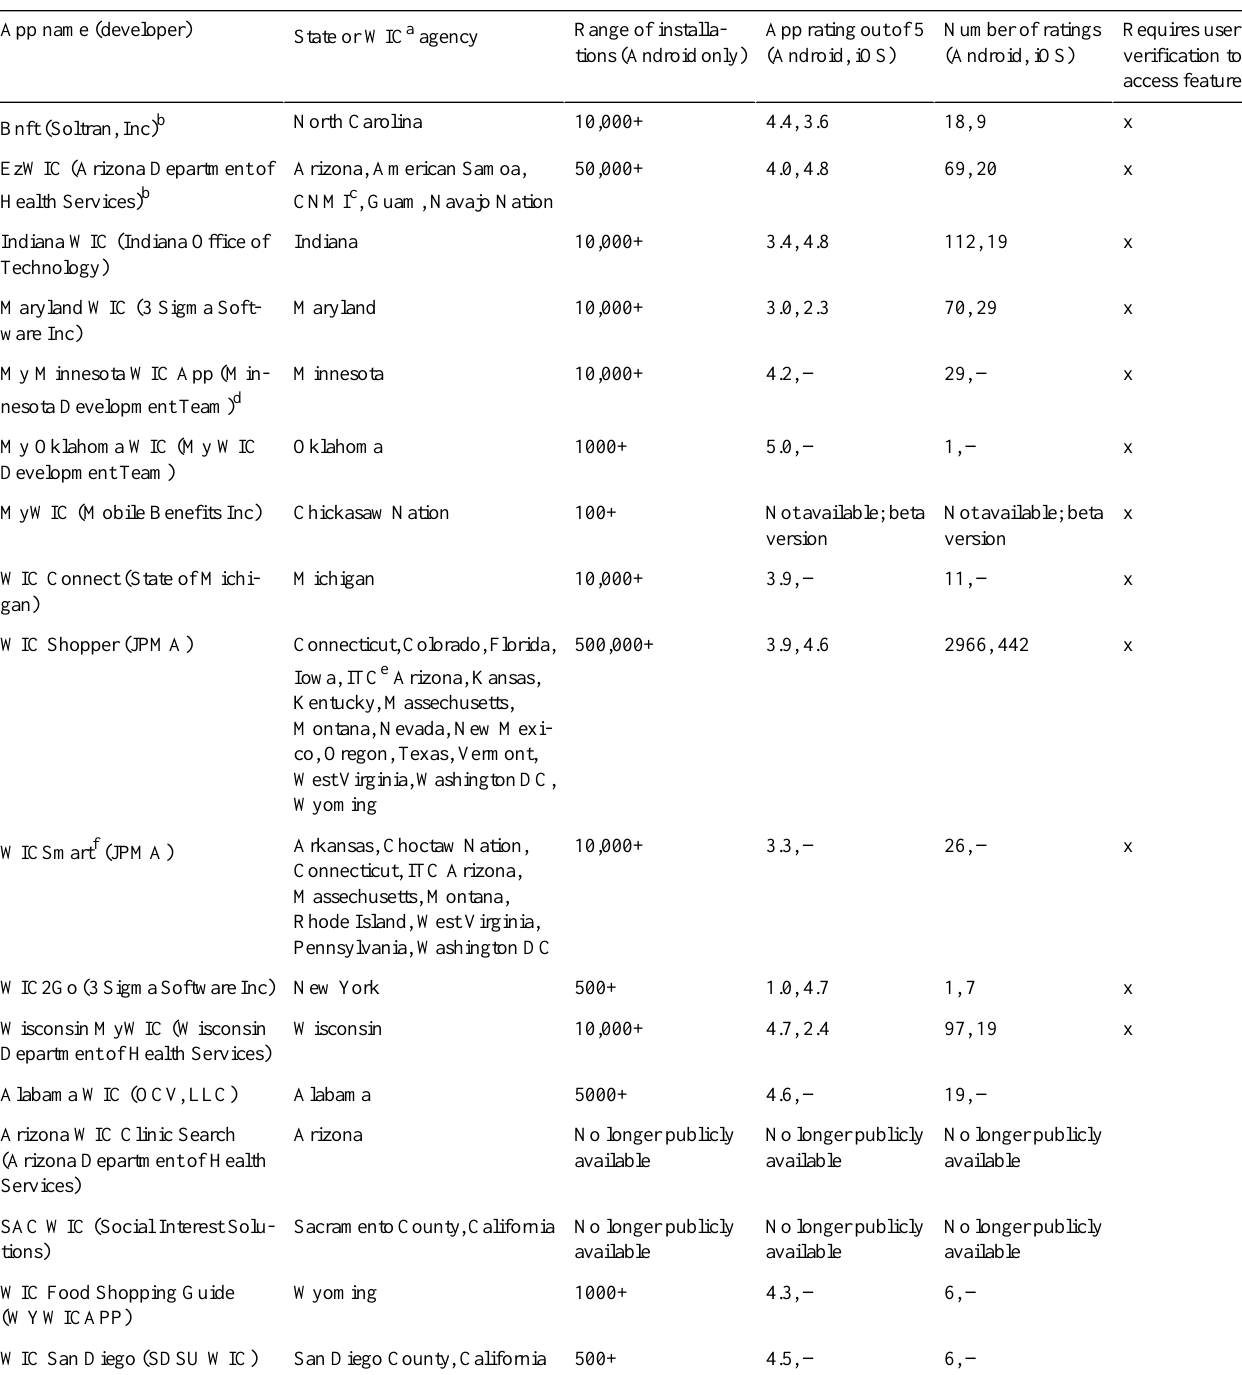
Table 1. Mobile phone apps for Women, Infants, and Children programs available for public download.